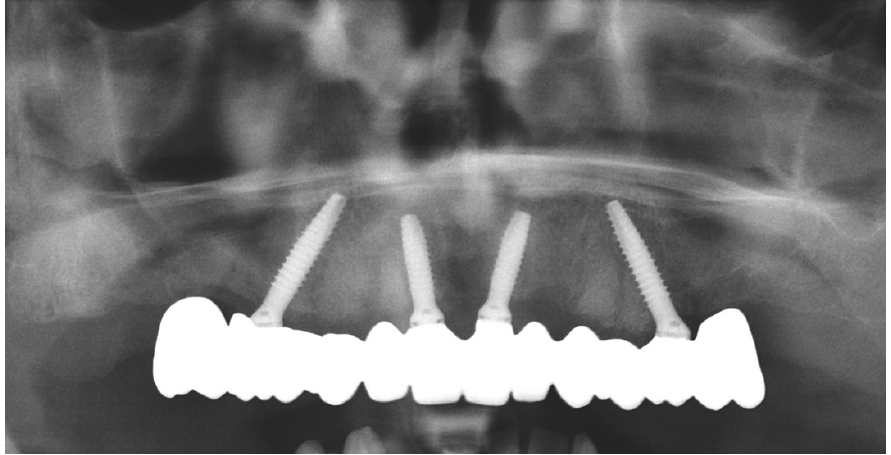
Figure 9. Panoramic radiograph showing good prosthetic fit and absence of bone remodeling after definitive restoration.